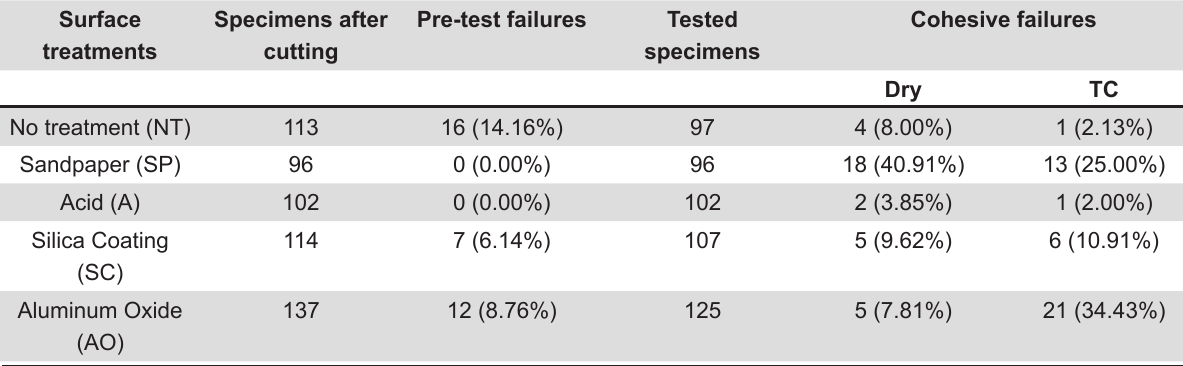
Table 1- Percentage of pre-test and cohesive failures